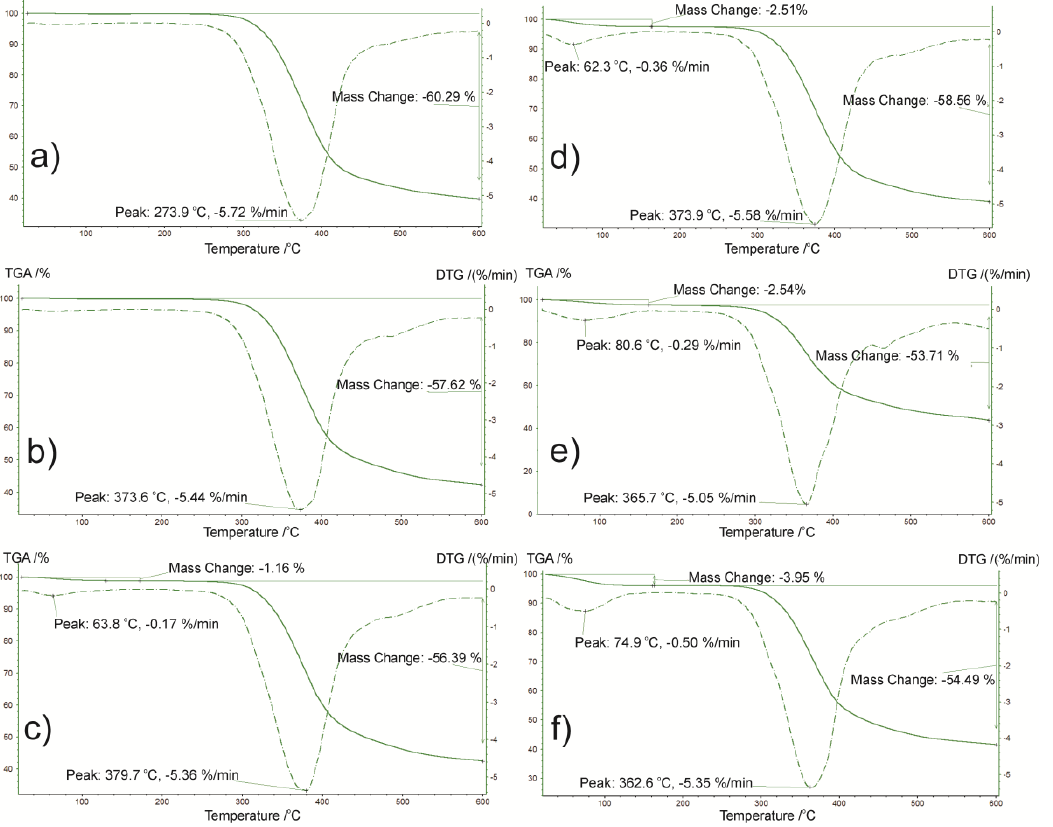
Figure 5. Thermogravimetric analysis (TGA)/derivative thermogravimetry (DTG) curves of amorphous imatinib mesylate (IM) at ageing temperature 25 °C at different ageing times: ( a ) day 0, ( b ) 2 weeks, ( c